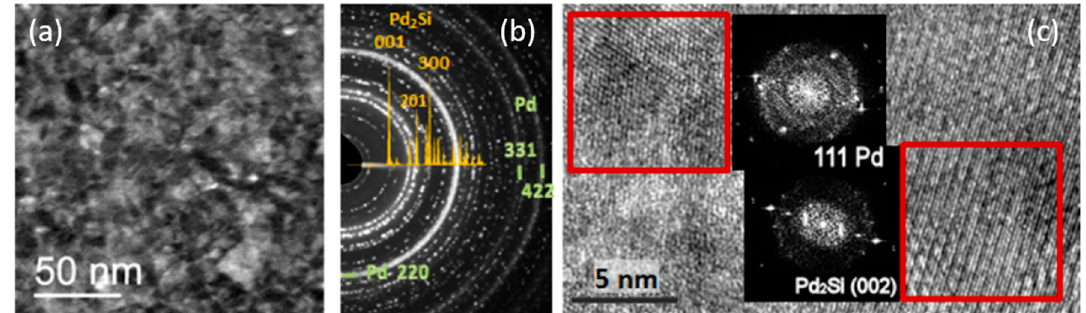
Figure 13. Plan-view TEM investigation of a 9 nm thick Pd film deposited on a-Si. ( a ) STEM-HAADF image revealing the grain contrast in the thin film. ( b ) selected area electron diffraction pattern showing the coexistence of polycrystalline Pd 2 Si and 111 fiber-textured Pd grains. ( c ) High resolution image; Fourier transform on selected grains are consistent either with fcc Pd or hexagonal Pd 2 Si lattice planes.